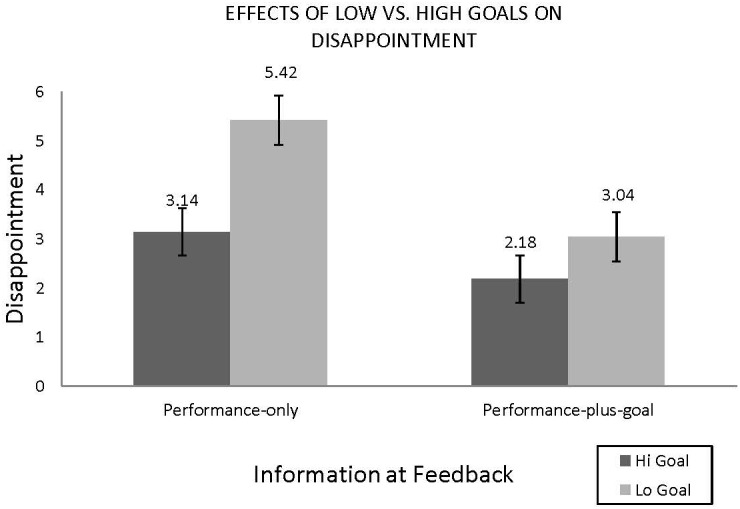
Study 1 results. N = 124, disappointment measured on 9-point scales (1 = not at all; 9 = extremely).